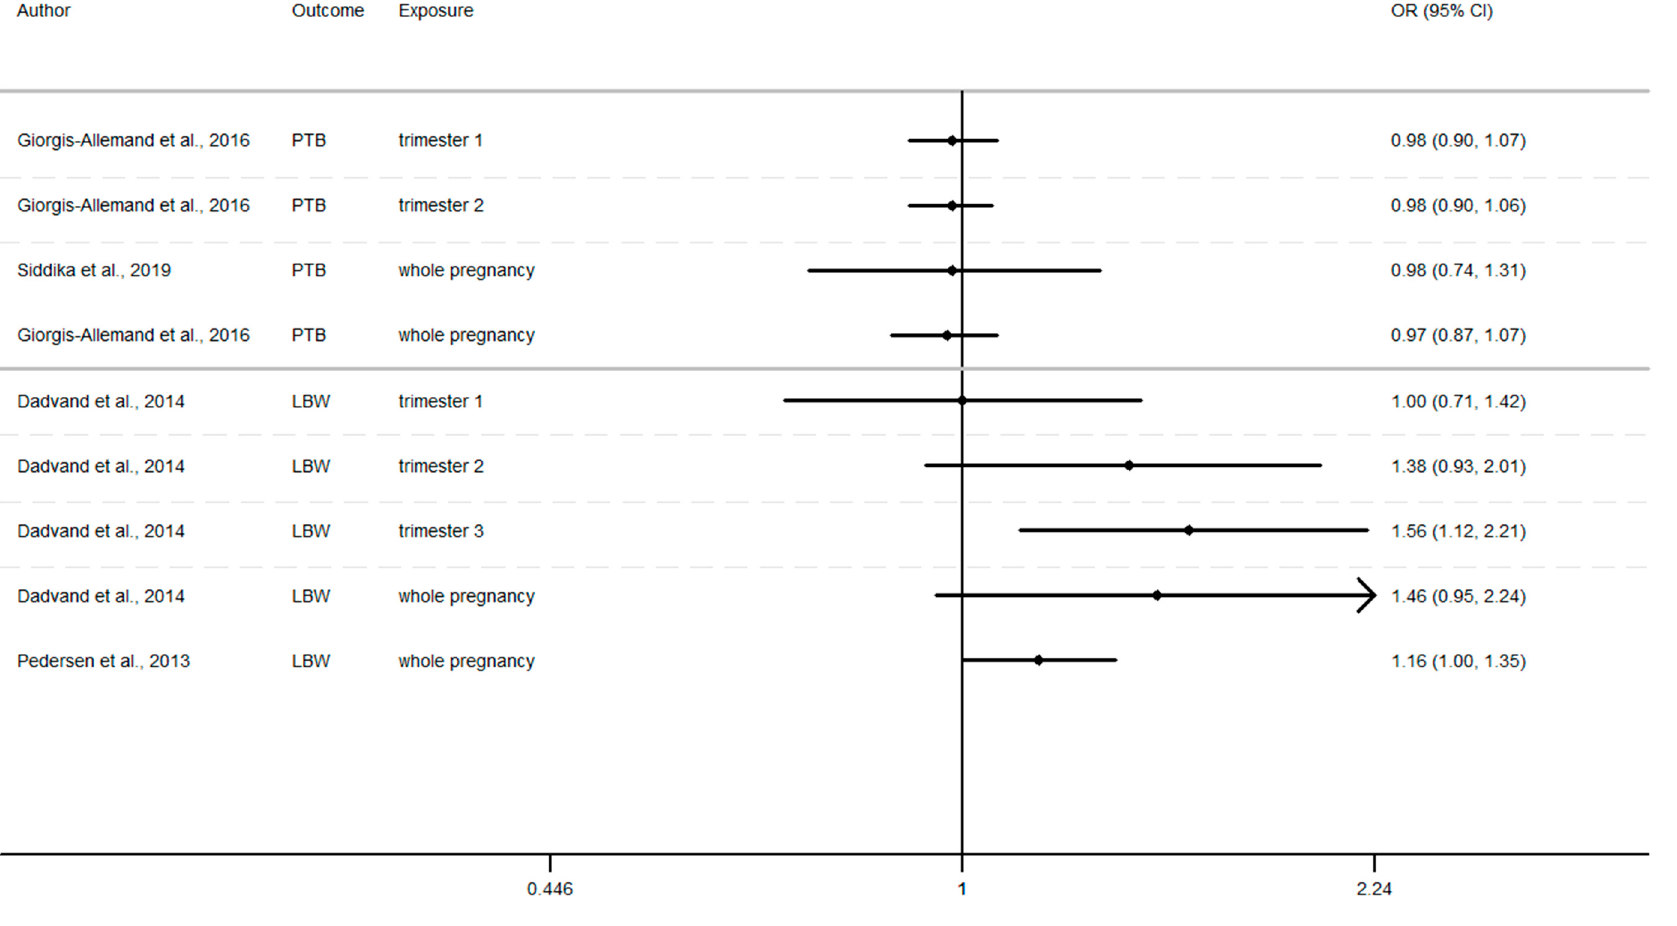
Figure 3. Risk of birth outcome for PM 10 exposure during different windows of exposure during pregnancy.